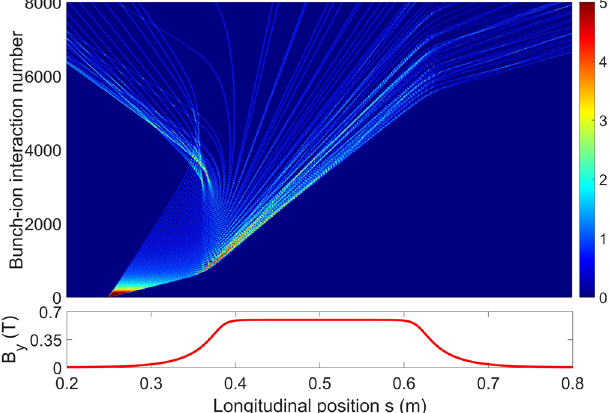
FIG. 3. Evolution of the ion longitudinal distribution when going trough a dipole magnet for various initial longitudinal velocities. The ion longitudinal distribution is shown in the top plot vs time (expressed in bunch-ion interactions) in ordinate and vs the longitudinal position s. The color scale shows the local density of ions (the number of ions per pixel). The bottom plot shows the vertical magnetic field B y as a function of the longitudinal position s . Results obtained using the NUAGE simulation code, see Sec. III v ¼ 500 m = s to 3000 m = s. A fraction of the ions are s reflected by the rising magnetic field when entering the dipole fringe field between s ¼ 0 . 35 m and 0.4 m. The minimum initial velocity of all the transmitted ions is v s 1300 m = s which is close to the value computed using ¼ 1350 m = s. The longitudinal velocity increase Eq. (5), v s 0 of the transmitted ions while inside the dipole, from s ¼ 0 . 4 m to s ¼ 0 . 6 m, corresponds to the longitudinal drift velocity v d , Eq. (4).